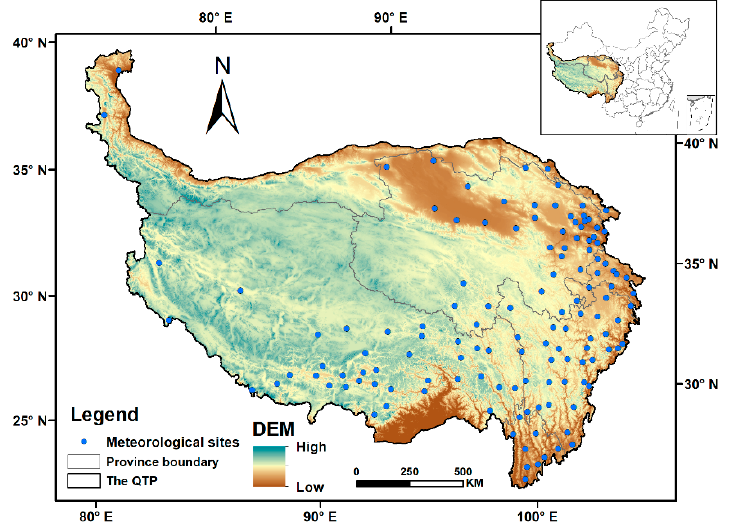
Figure 1. Location and spatial distribution of meteorological sites on the Qinghai–Tibet Plateau.